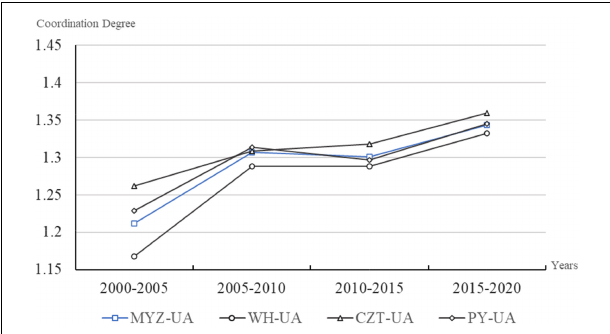
FIGURE 4 | Change of coordination degree of “construction land–population” from 2000 to 2020.